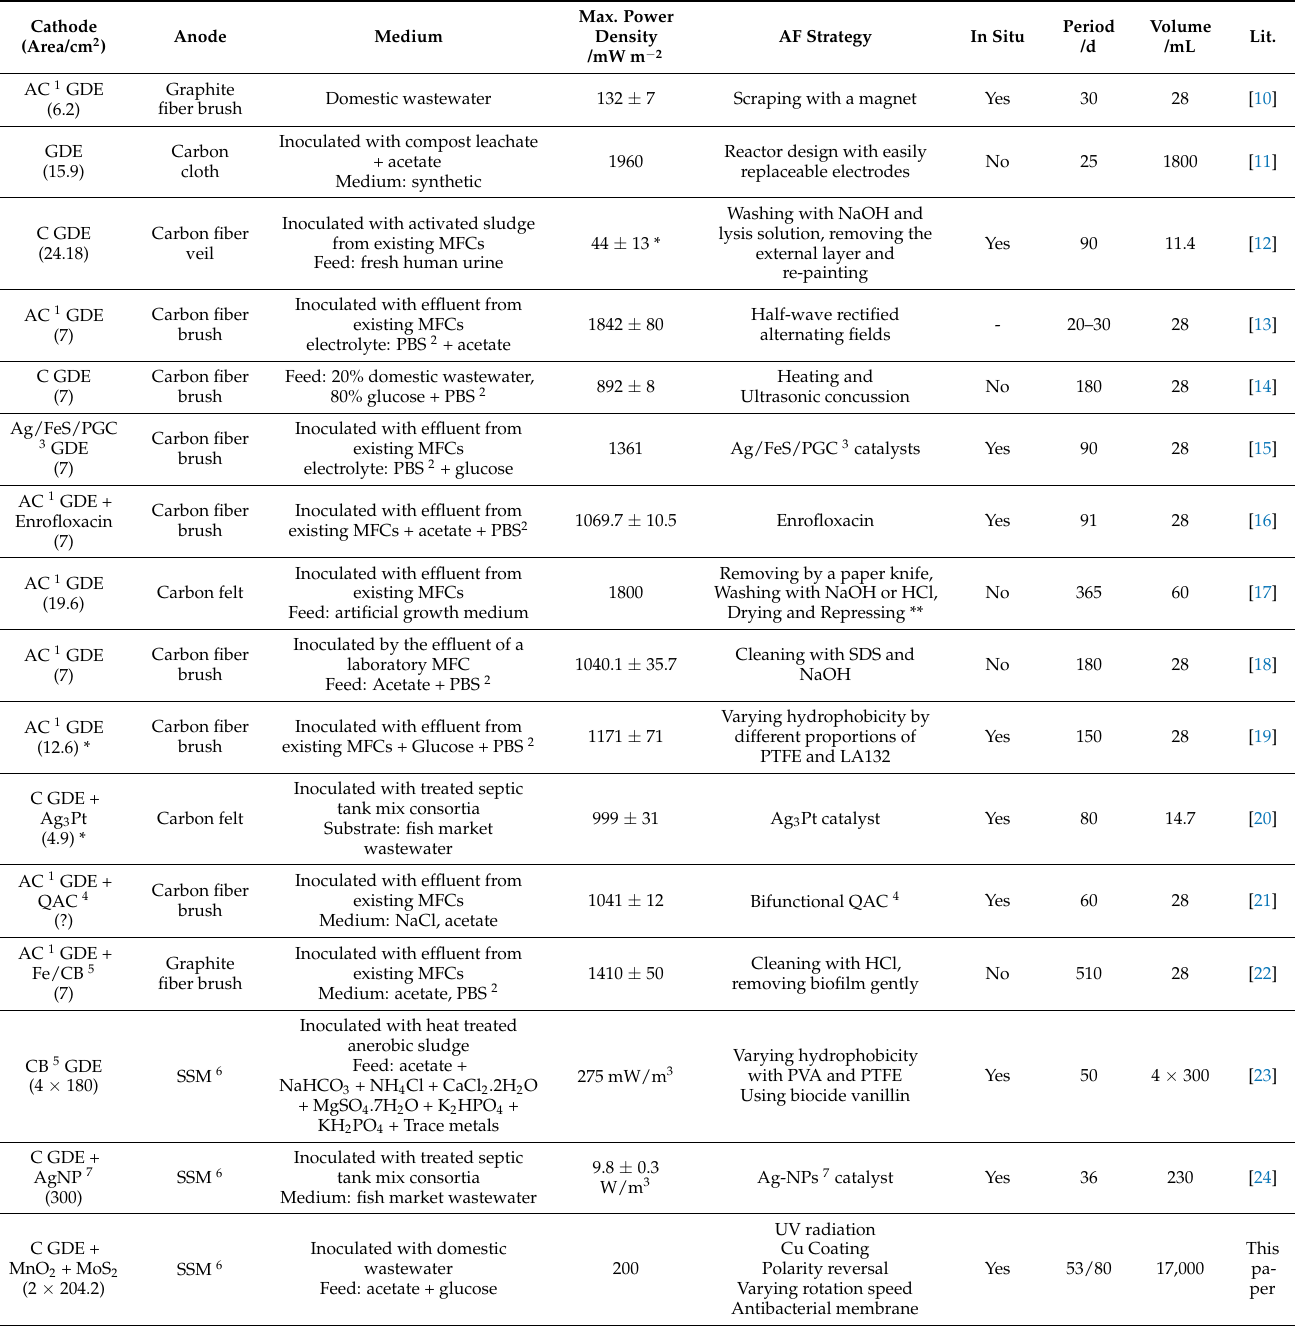
Table 1. Selected single-chamber microbial fuel cells with antifouling (AF)